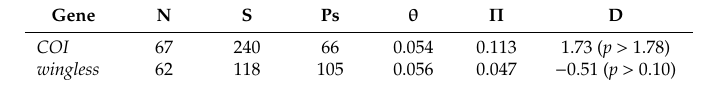
Table 3. Overall genetic indexes for the genus Panabachia . N refers to the number of individuals sampled; S, number of segregating sites; Ps, number of parsimony informative sites; π , is a measure of nucleotide diversity; θ is a measure of genetic diversity; D represents Tajima’s D, a neutrality test.